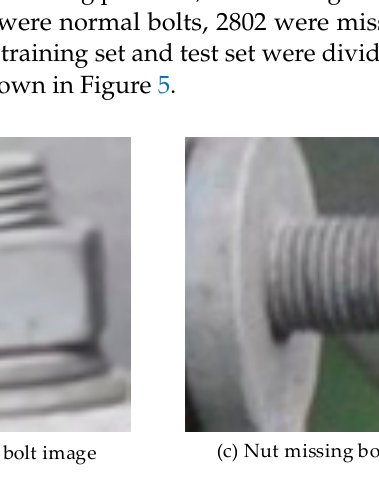
Figure 5. Three categories of bolt image samples.